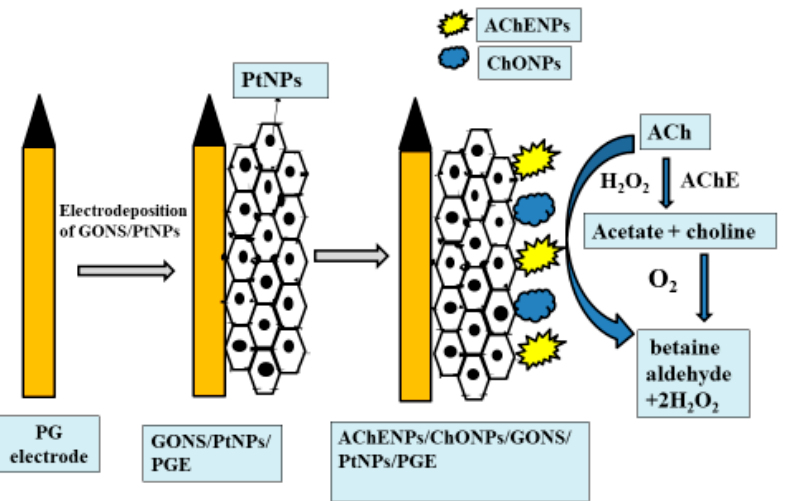
Figure 1. Cyclic voltammogram (CV) curve in 2.5 mM K 3 Fe(CN) 6 /K 4 Fe(CN) 6 (1:1) with 40 continuous polymerization circles ( − 1.1 to 0.1 V) at a scan rate of 20 mV/s for bare PGE and GONS/PtNPs/PGE. (GONS = Graphene oxide nanosheets; PtNPs = Platinum nanoparticles; PGE = Pencil graphite electrode).